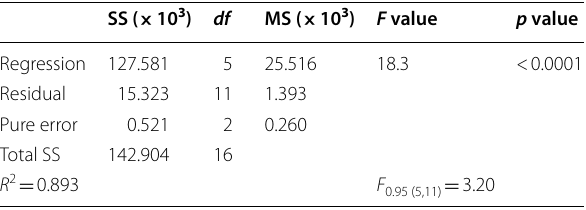
Table 4 Analysis of variance (ANOVA) for the experimental results of the central composite design used for bikaverin production by F. oxysporum CCT7620